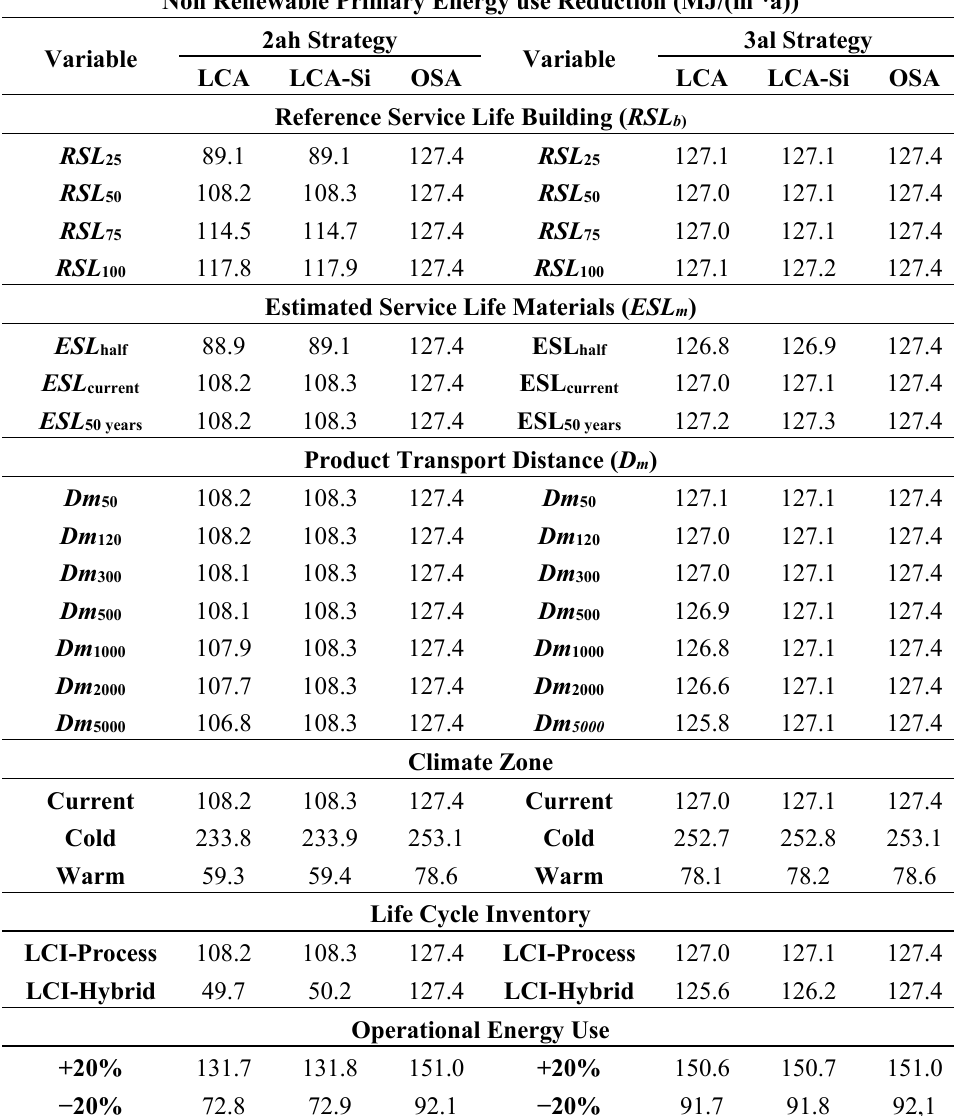
Table 7. Sensitivity analysis results for refurbishment strategies 2ah (advanced efficiency level ventilated façade system with high embodied energy products and 3al (advanced efficiency level external insulation system with low embodied energy